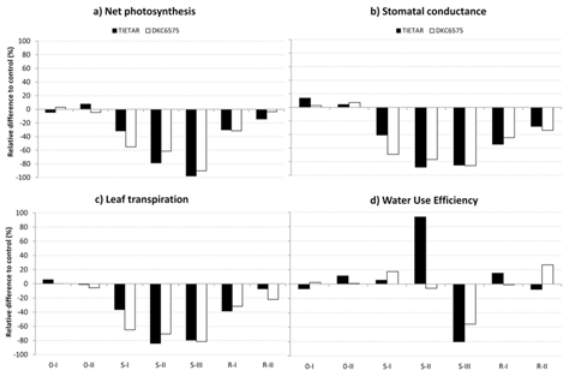
Fig 3. Percentage variation of the drought stress treatment (irrigation 0% of field capacity) in respect to the control (irrigation 100% of field capacity) for gas exchanges parameters measured in the growth chamber experiment. The straight line at the “ 0 ” level represents the control, and histograms represent the relative variations of drought stressed plants.